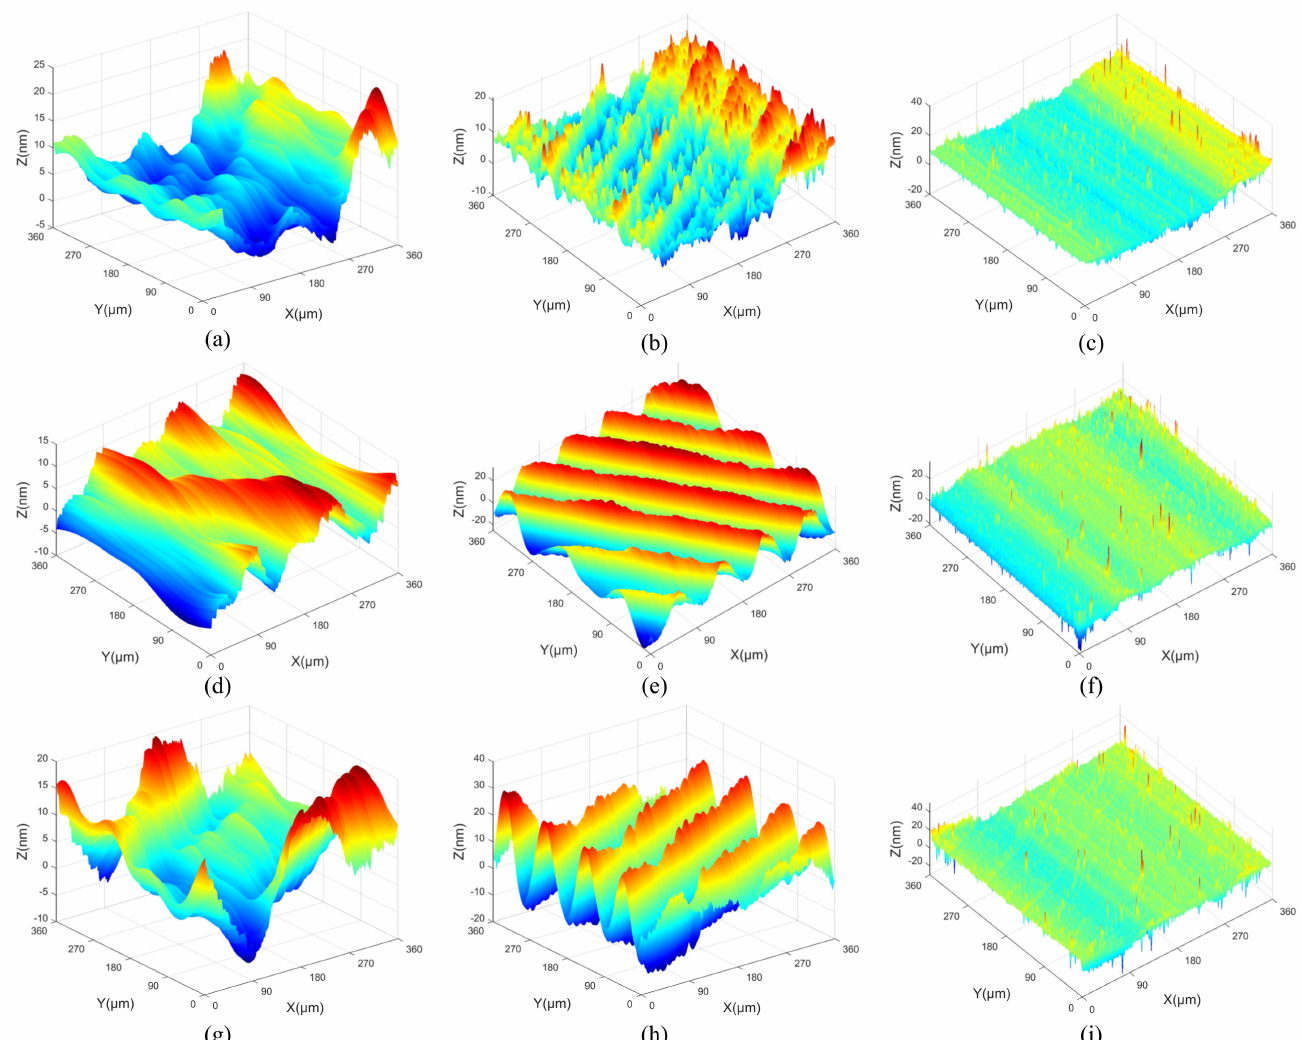
Figure 7. The reconstruction results of spatial frequency features with different cutting depths: ( a ) low-frequency of a p = 3 µ m, ( b ) middle-frequency of a p = 3 µ m, ( c ) high-frequency of a p = 3 µ m, ( d ) low-frequency of a p = 6 µ m, ( e ) middle-frequency of a p = 6 µ m, ( f ) high-frequency of a p = 6 µ m, ( g ) low-frequency of a p = 9 µ m, ( h ) middle-frequency of a p = 9 µ m, ( i ) high-frequency of a p = 9 µ